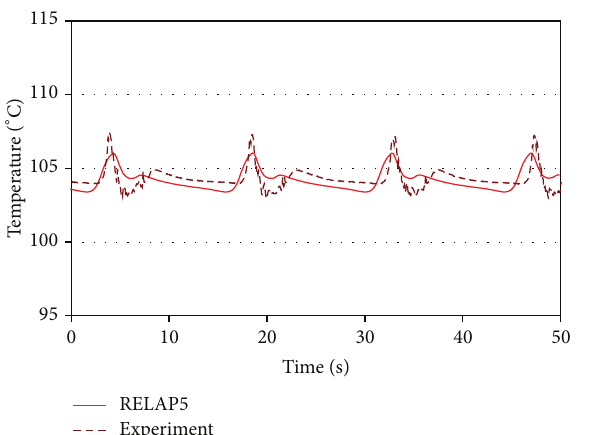
Figure 16: Middle riser water temperatures, test I-2.